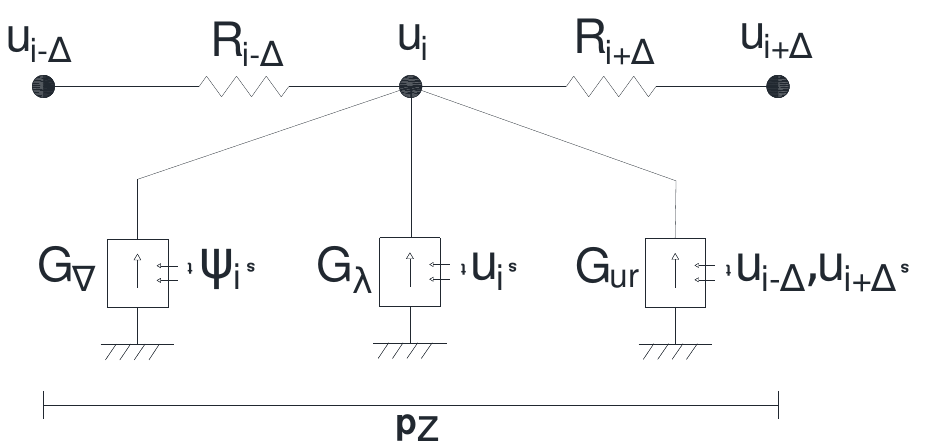
Figure 4. Nomenclature and network model of the volume element for variable u. Radial domains.